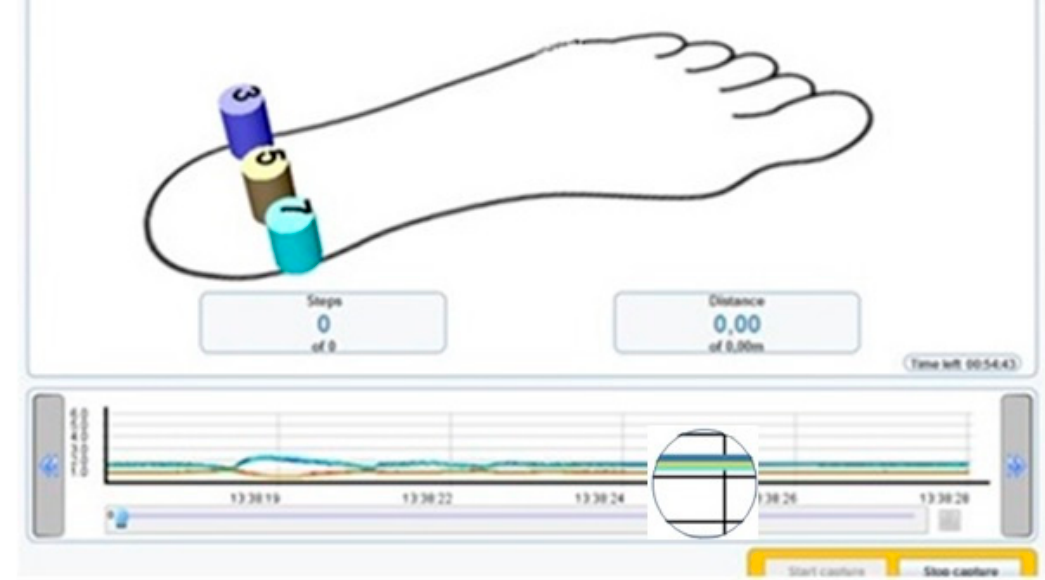
Figure 3. Cast taking moment with sensors and pressure reading, observing on the graph the reading of a single line when the pressures equalize (in that moment, the pressure registered by 3, 5 and 7 sensors are the same).